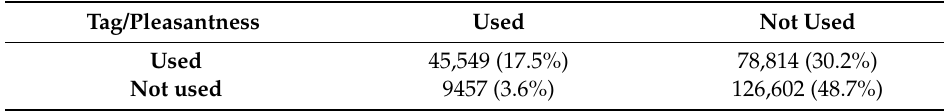
Table 18. Cross table between pleasantness and tags. Tag/Pleasantness Used Not Used Used 45,549 (17.5%) 78,814 (30.2%) Not used 9457 (3.6%) 126,602